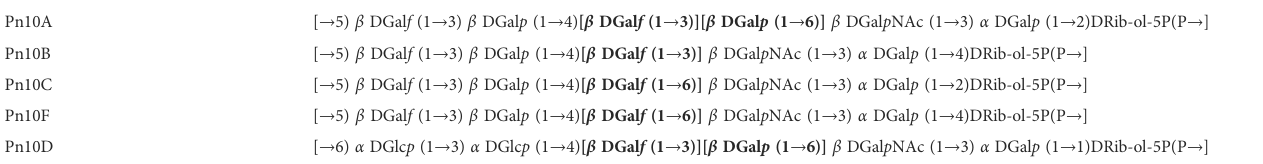
TABLE 1 Line structures of S. pneumoniae repeating units for serogroup 10 CPSs, side groups in bold.